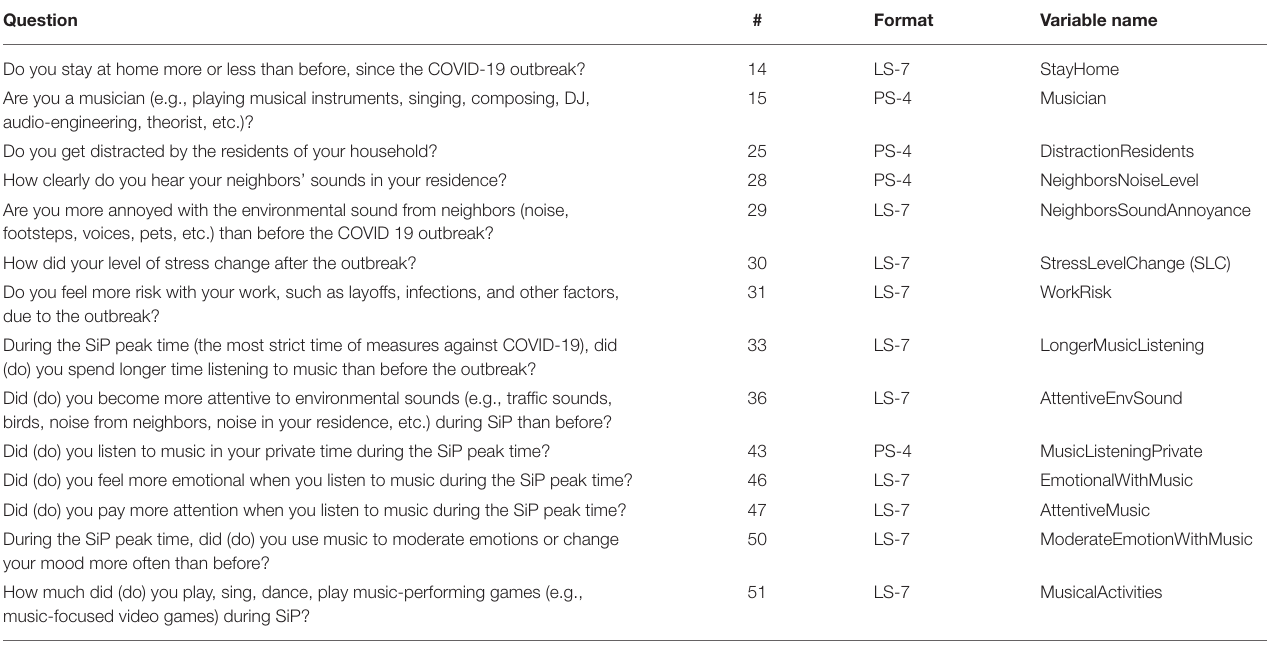
TABLE 1 | List of key questions: Question sentences and numbers, response formats, and variable names. Question #